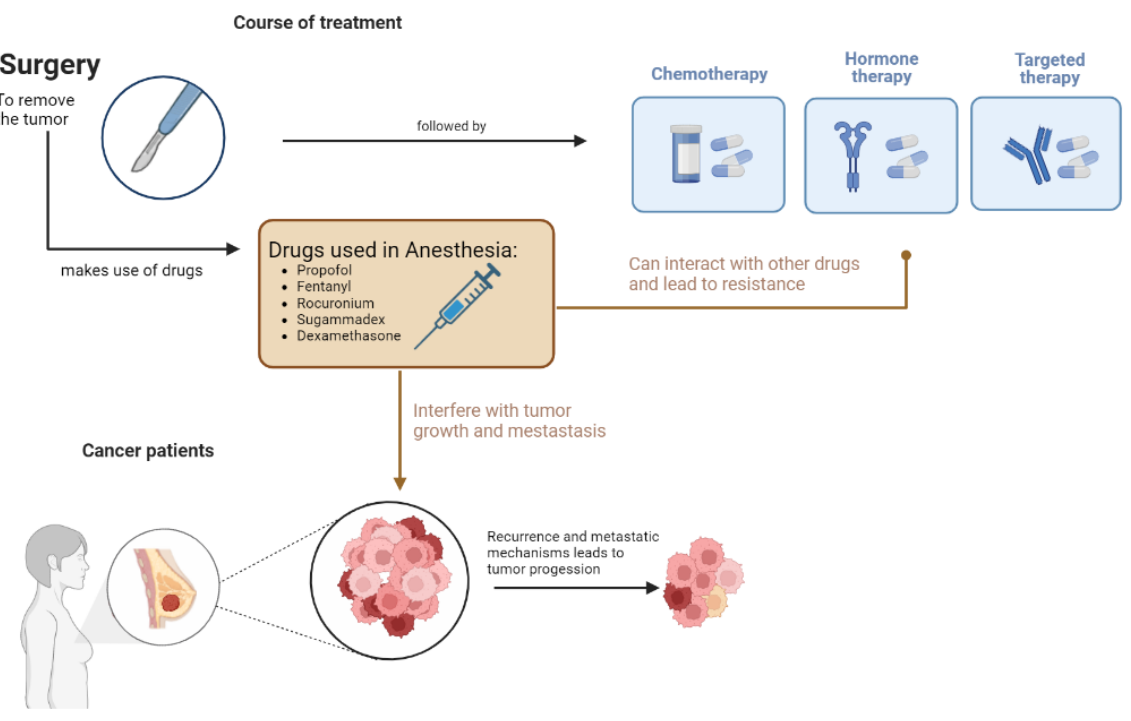
Figure 5. S chematization of the effect of drugs used in anesthesia in cancer progression and metas-